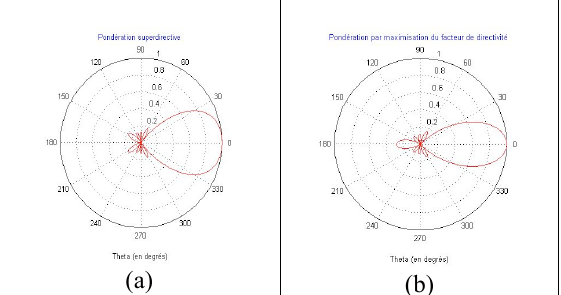
Figure 4. Directivity diagrams for superdirective (a) and optimal (b)